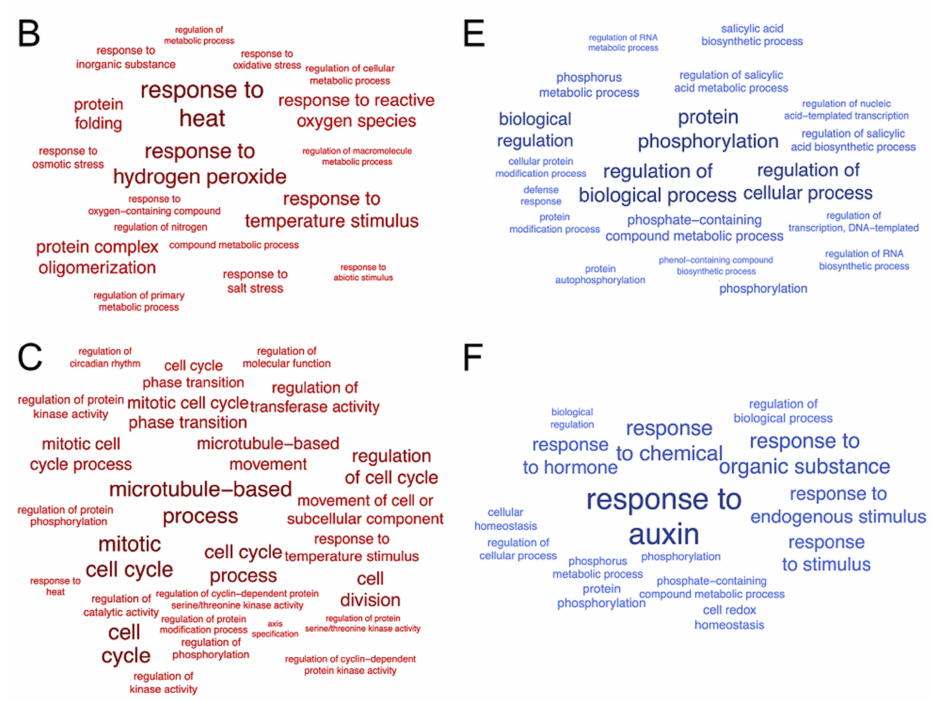
Figure 2. Gene ontology (GO) bias word clouds (biological process). Word clouds of genes upregu- lated and downregulated in mock-inoculated potato at 28 ◦ C ( A , D ), PVY-infected potato at 22 ◦ C ( B , E ) and 28 ◦ C ( C , F ). Font size correlates with enrichment significance (see Table S4; g:Profiler software, p value < 0.05, corrected for multiple hypotheses testing by the Benjamini-Hochberg correction procedure